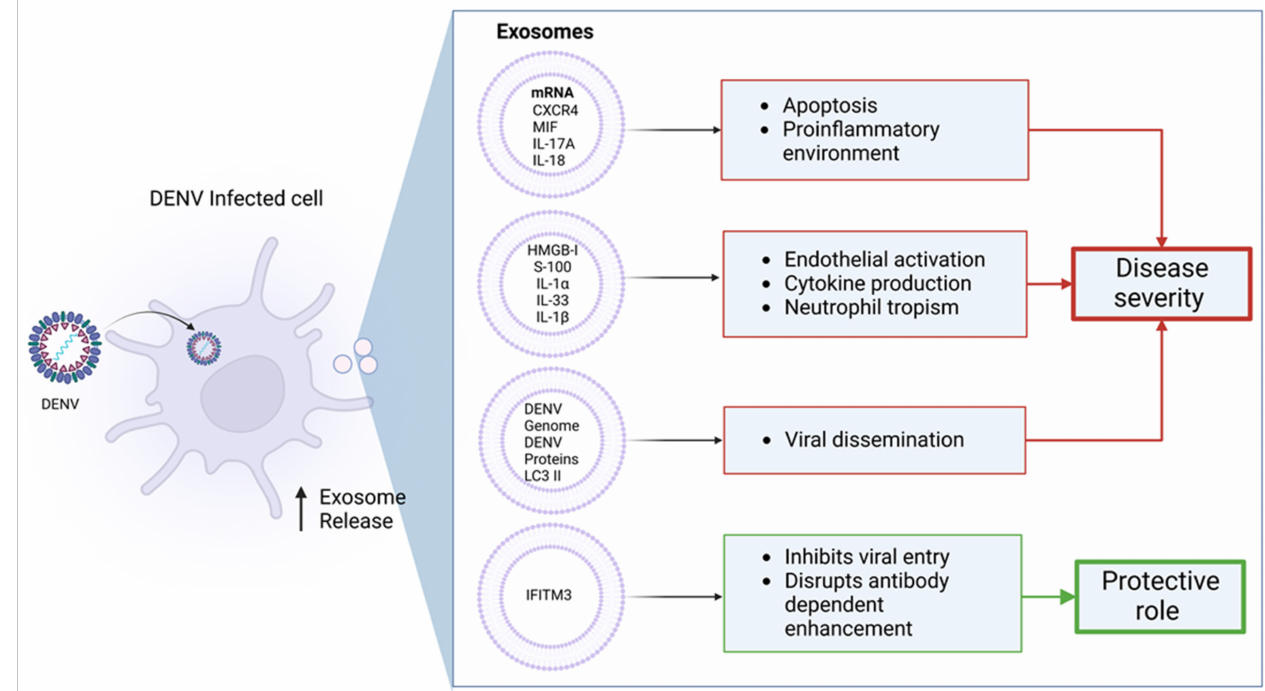
Figure 4. Exosomes during dengue virus infection. DENV infection induces the secretion of small membrane vesicles (known as exosomes) from infected cells to the extracellular space. These ex- osomes perform different functions such as the induction of cytokine production, apoptosis, en- dothelial cell activation, viral dissemination, inhibition of viral entry, and interference with ADE phenomenon depending on its content and cell origin, contributing to disease severity or protection against